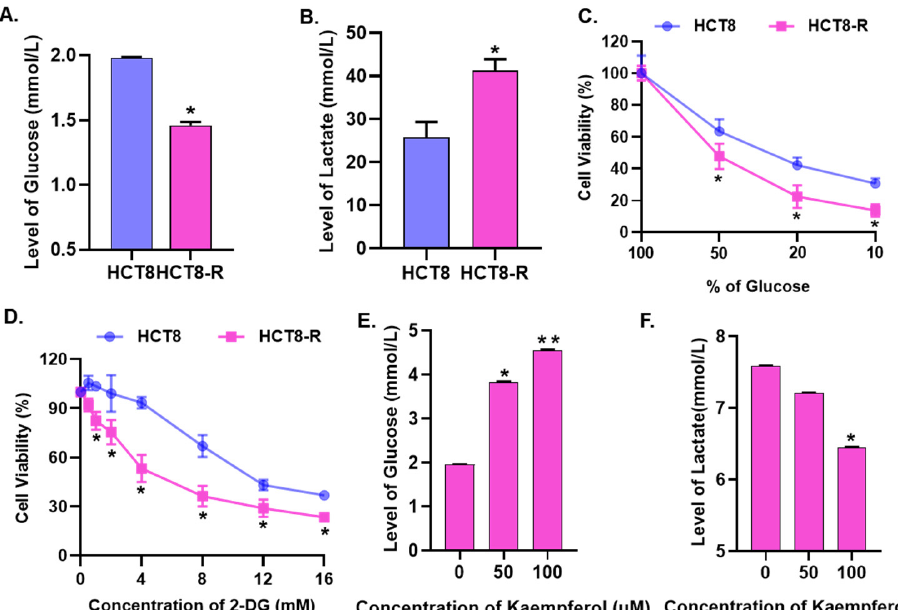
Figure 3. Kaempferol promotes 5-Fu sensitivity by inhibiting glycolysis. ( A ) Analysis of glucose content in HCT8 and HCT8-R cell culture media. ( B ) The content of lactate was detected in HCT8 and HCT8-R cell culture media. ( C ) After HCT8 and HCT8-R cells were cultured in glucose deprivation medium containing 10%, 20%, 50% and 100% glucose for 24 h, a CCK-8 assay was used to detect cell survival. Data represent means ± SD from three independent experiments. ( D ) After HCT8 and HCT8-R cells were treated with various concentrations of 2-DG (2-deoxy-d-glucoside) (0 mM, 0.5 mM, 1 mM, 2 mM, 4 mM, 8 mM,12 mM and 16 mM) for 48 h, a CCK-8 assay was used to detect cell survival. Data represent means ± SD from three independent experiments. ( E ) After HCT8-R cells were treated with kaempferol for 48 h, the content of glucose in the culture medium was detected. ( F ) After HCT8-R cells were treated with kaempferol for 48 h, the content of lactate in the culture medium was detected. * p < 0.05, ** p < 0.01.